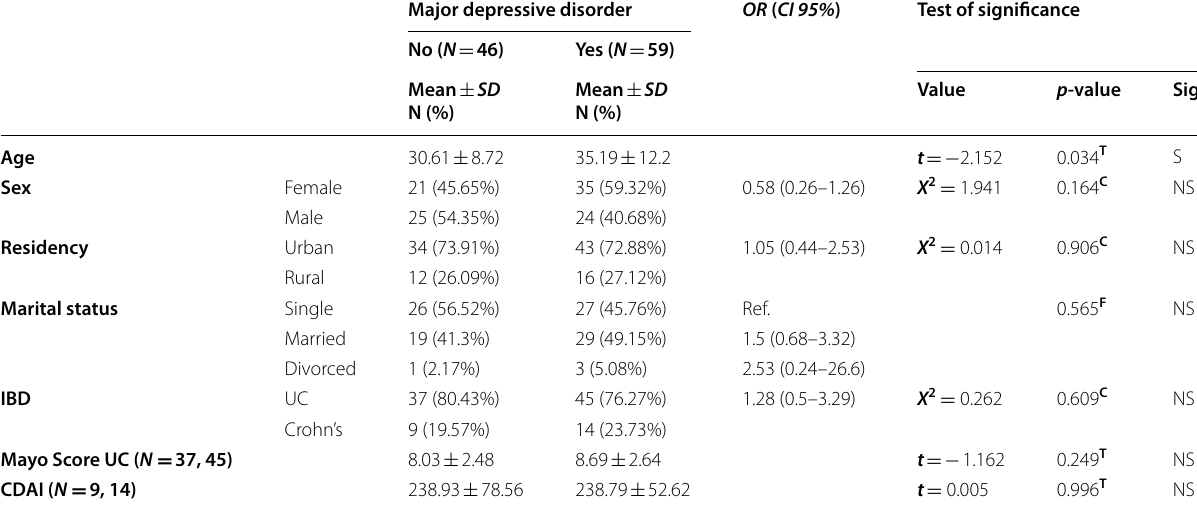
Table 4 Multivariable logistic regression analysis of the relationship between patient demographic and disease characteristics and the existence of major depressive